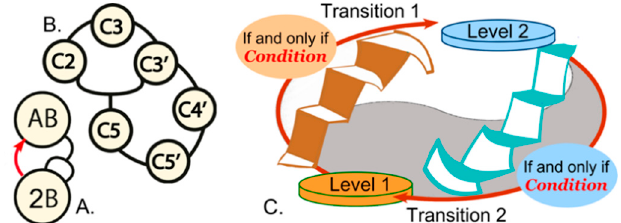
Figure 1. Biological process control blocks. ( A ) . Simple autocatalysis. Reaction of molecules A and B gives rise to two B molecules, which therefore increase the rate at which B is produced. ( B ) . A reflexive autocatalytic set, often called a Reflexive Autocatalytic Food Set (RAFS). The network is closed because the product of catalyst 5 is the substrate for catalyst 2 (reproduced from [19] ). ( A ) and ( B ) were adapted from [19] . ( C ) . Elements of reciprocally coupled gating, presented as a strange loop [20]. White stairs on left and right sides are filtered by an “if and only if” condition as both ascend from level to level and the antecedent of each staircase is the consequent of the other.